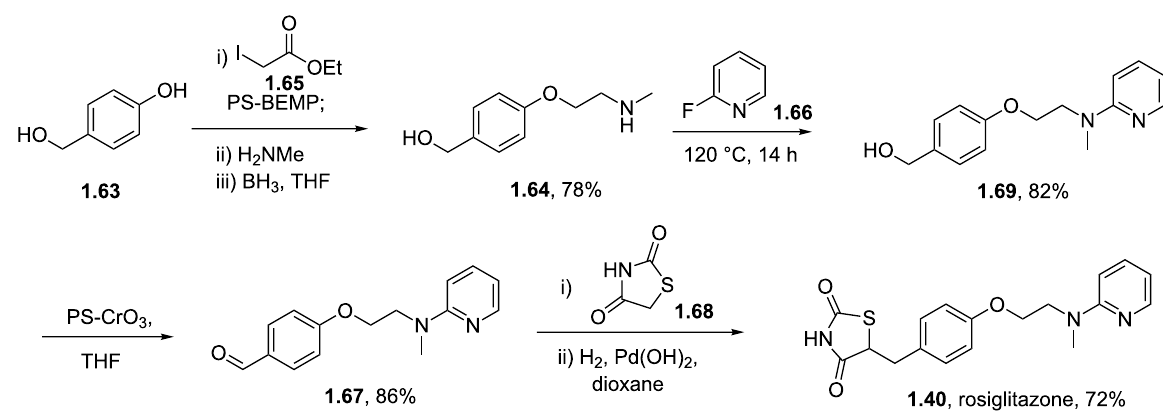
Scheme 11: Polymer-assisted synthesis of rosiglitazone.